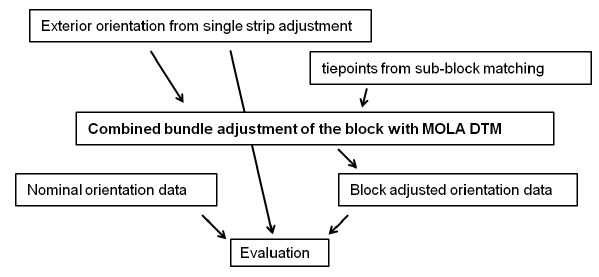
Figure 4: Evaluation of the bundle adjustment results